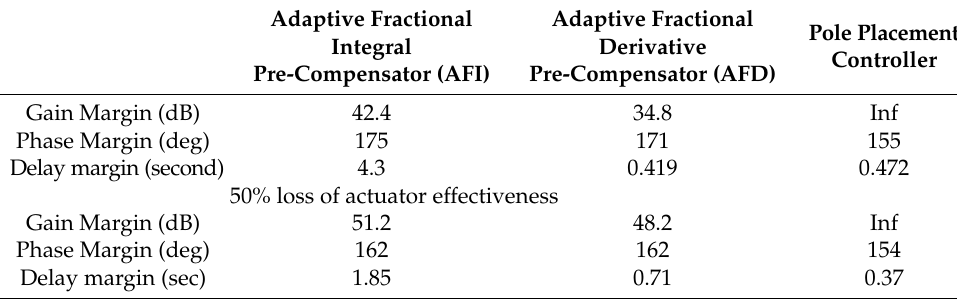
Table 3. Obtained numerical results of the closed-loop phase and gain